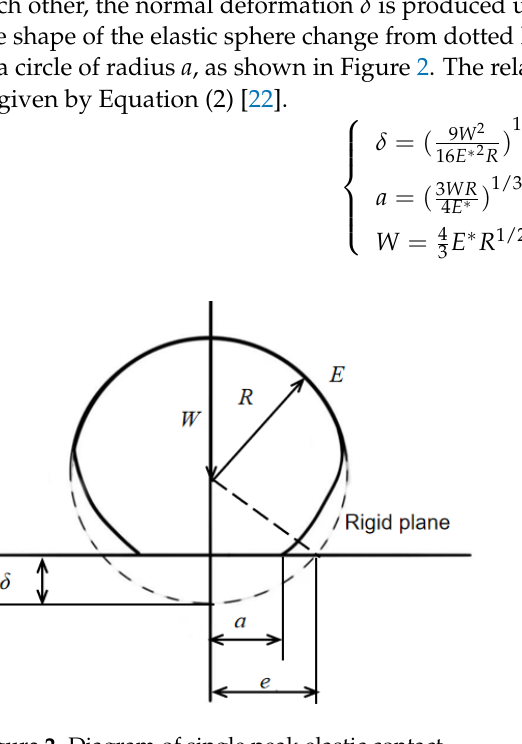
Figure 2. Diagram of single peak elastic contact.